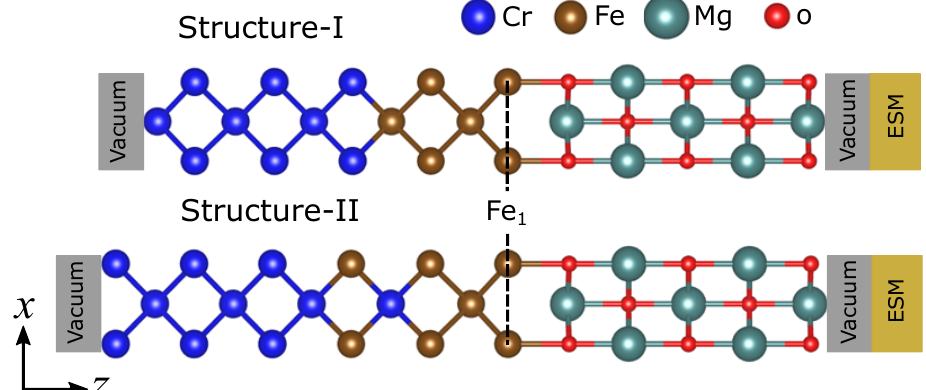
Figure 1. Computational model for structure-I (without alloying) and structure- II (with